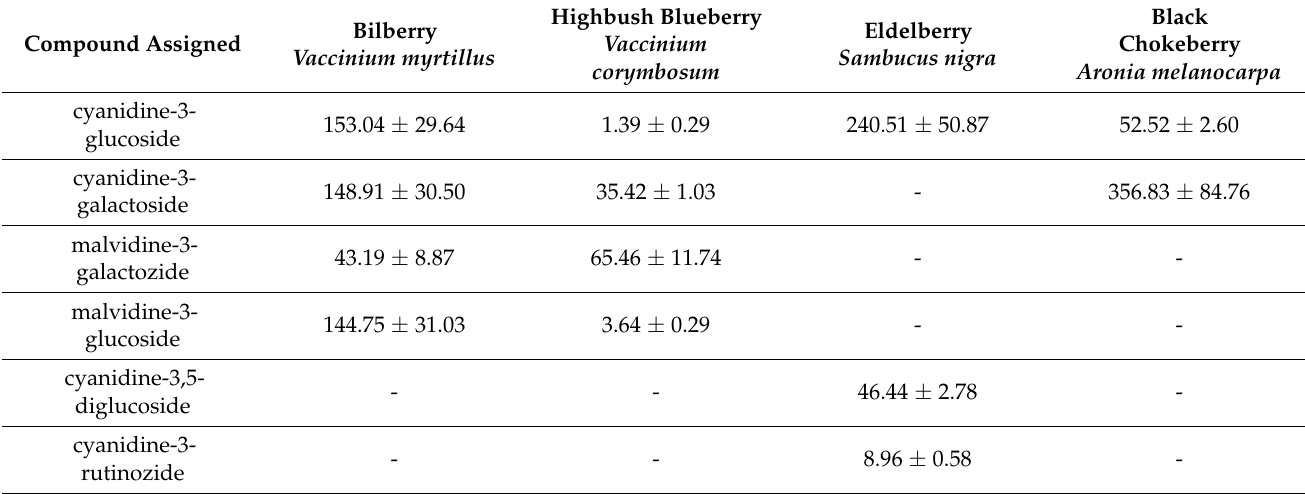
Table 3. Quantitative anthocyanin content of ethanol extracts by LC-MS-IT-TOF analyses [ppm]. (-: absence).